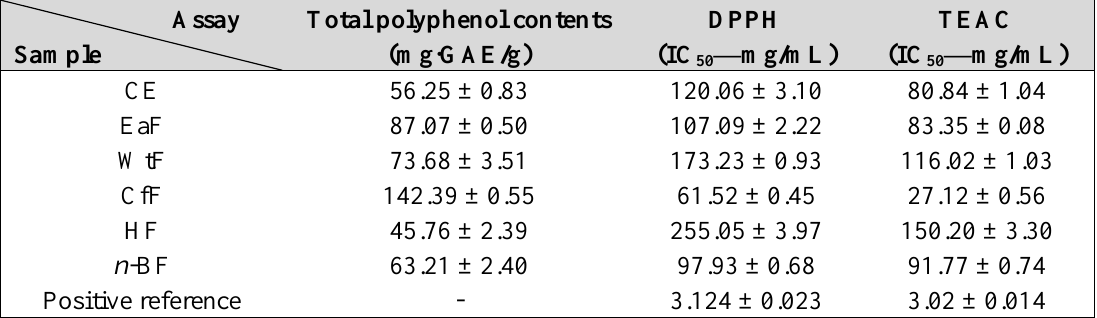
Table 4. Total polyphenol contents, DPPH radical scavenging activity and Trolox equivalent antioxidant capacity (TEAC) of Herissantia